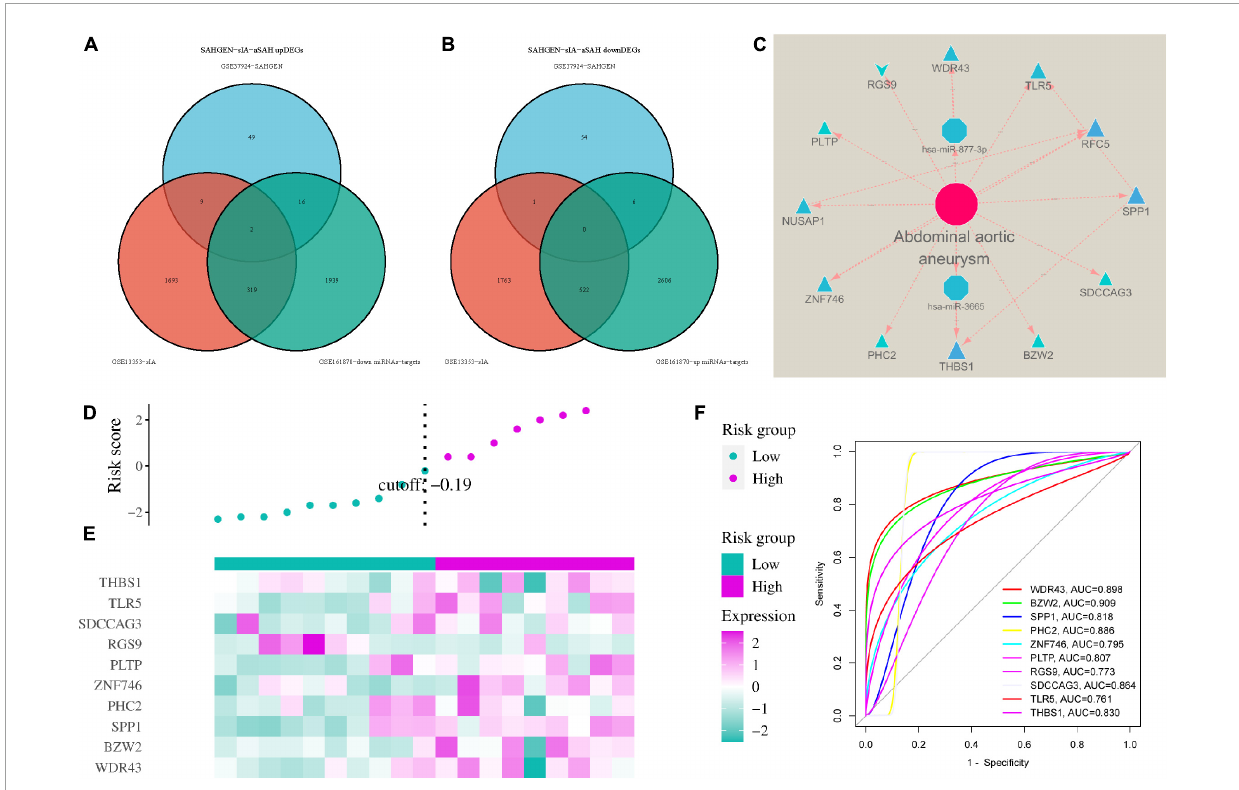
FIGURE3 Constructing an interaction network between differentially expressed microRNAs and genes. (A) Venn diagram showing co-upregulated target genes. (B) Venn diagram showing co-downregulated target genes. (C) Protein-protein interaction (PPI) network between DEmiRNAs and mRNAs. (D,E) Development of a risk model and evaluation of core genes in cerebral vasospasm (CV) prediction. (F) Receiver operating characteristic (ROC) curves of core genes for evaluation of the risk